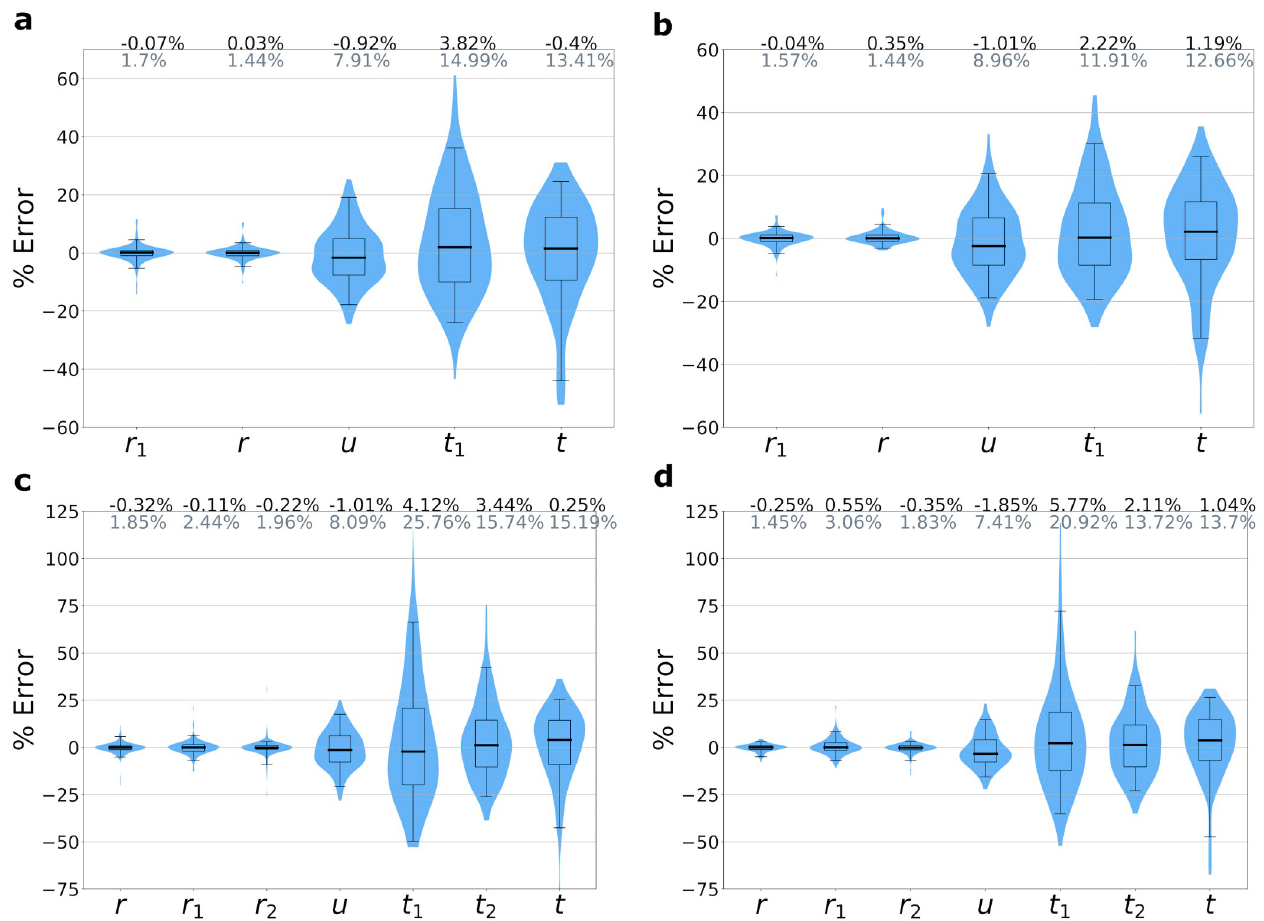
Fig 2. Accuracy of parameter inferences from simulated data. We simulated tumor growth by performing a Monte Carlo simulation, which simulates the birth, death, and accumulation of mutations in the individual cells that make up a tumor, and generates the mutation frequency and tumor size data used by the estimates. Simulations are of fast-growing tumors with (a) single driver subclone and mutation rate u = 1, (b) single driver subclone and u = 3, (c) two nested driver subclones with u = 1, and (d) two sibling driver subclones with u = 1. Mean percent errors (MPEs) of estimates are shown in black above the plots, and mean absolute percent errors (MAPEs) are shown in gray. Boxes contain 25th-75th quartiles, with median indicated by thick horizontal black line. Whiskers of boxplots indicate 2.5 and 97.5 percentiles. Violins are smoothed density estimates of the percent error data points. Complete parameter values and number of runs are included in S1